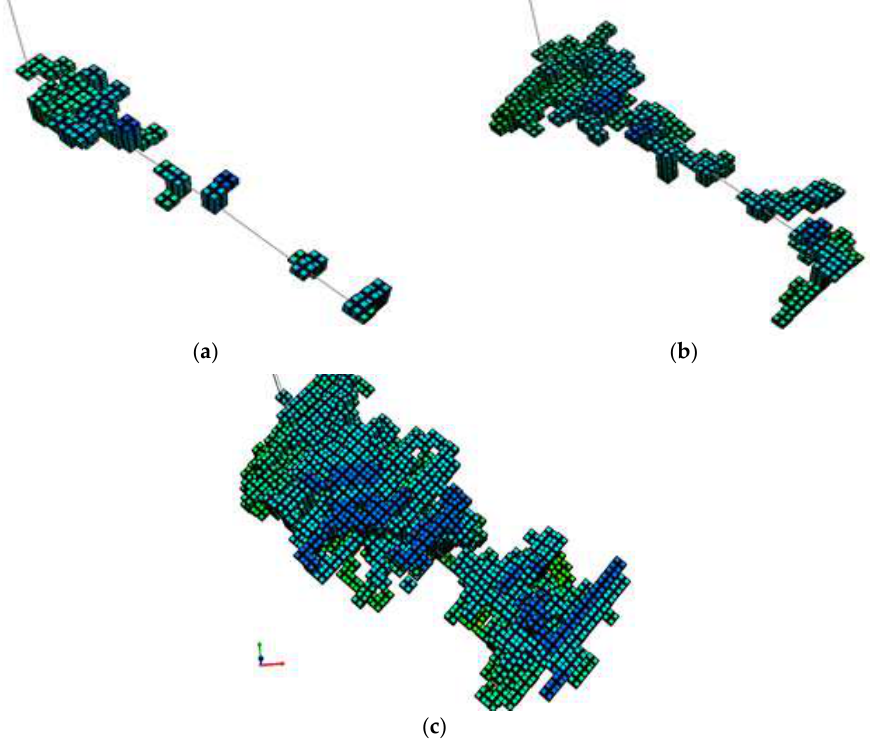
Figure 9. Constructed SRV. ( a ) Flush SRV, ( b ) Conductivity SRV, and ( c ) Hydraulic SRV for the target reservoir. (Colors of the grids indicate the top depths).